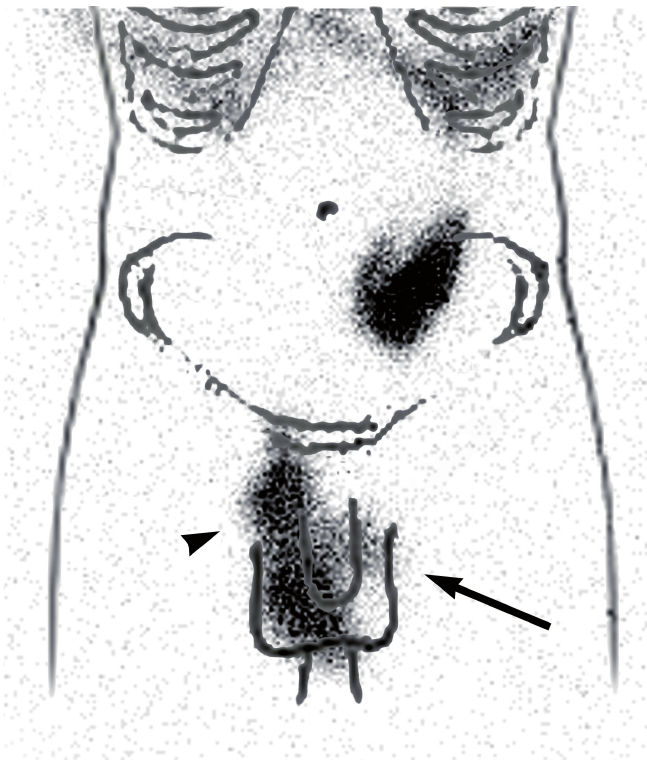
figure 3 - sectorial peritoneal 99mTc-phytate scintigraphy post-peritoneal lavage image over anatomical reference contour showing the right inguinal and scrotal uptake of radiotracer (head arrow) and left inguinal uptake